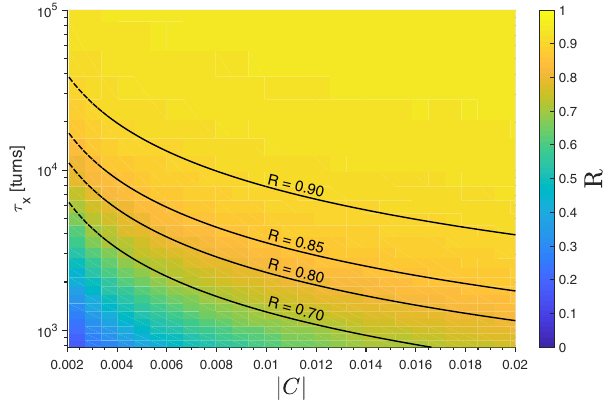
FIG. 7. Quality of emittance exchange for various values of the horizontal damping time and coupling for a fixed value of S ¼ 1 ¼ 2 . 1 j C j . and Δ ext